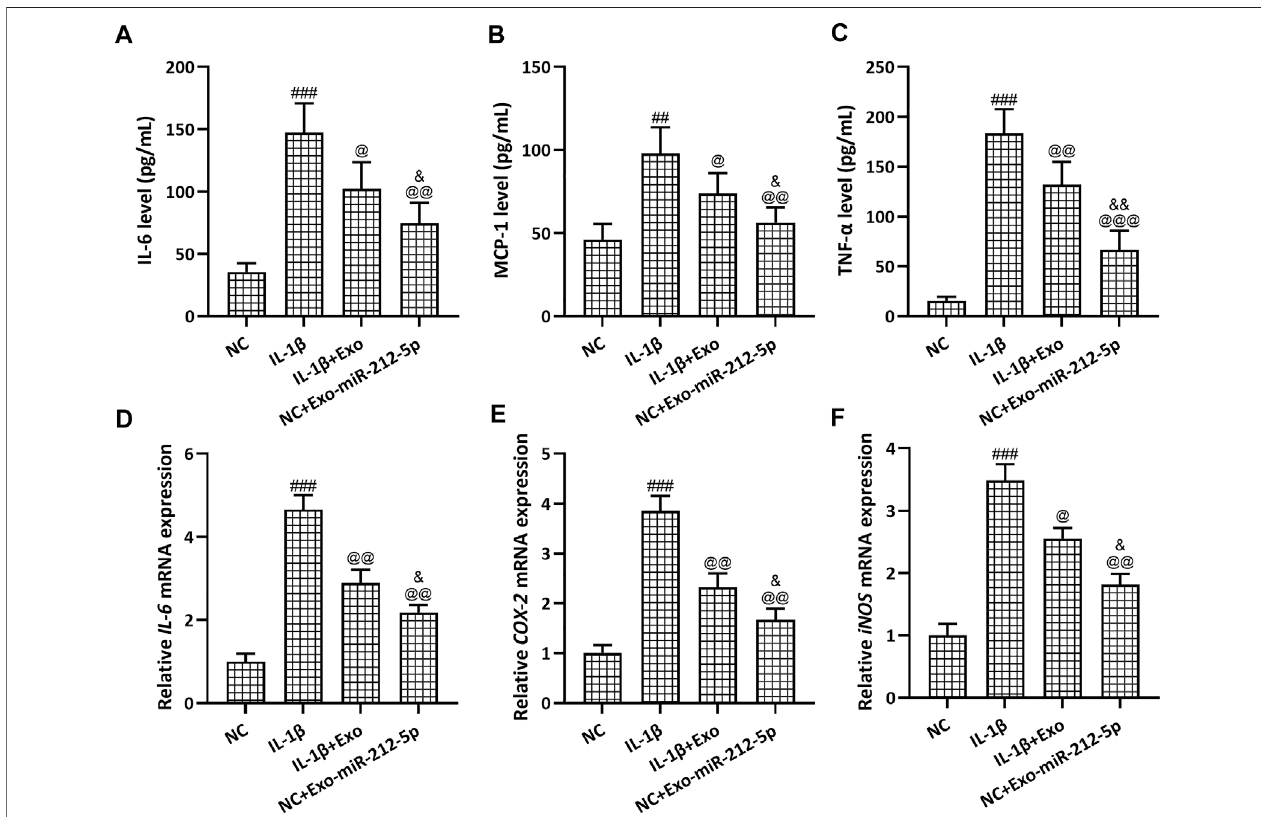
FIGURE 7 | SMSC-212-5p-Exos attenuated IL-1 β induced in fl ammatory responses in chondrocytes. IL-1 β induced chondrocytes were treated with SMSC-Exos or SMSC-212-5p-Exos for 48 h. IL-6, MCP-1, and TNF- α production in cellular supernatant were measured by ELISA (A – C) . mRNA levels of IL-6 , COX-2 , and iNOS from celllysisweretested byqRT-PCR (D – F) . n =6foreach groupinELISAanalysis, n =3foreach groupinqRT-PCRtest. ## p < 0.01, ### p < 0.001compared toNC. @ p < 0.05, @@ p < 0.01, @@@ p < 0.001 compared to IL-1 β . & p < 0.05, && p < 0.01 compared to IL-1 β +Exo. One-way ANOVA followed Dunn ’ s multiple comparisons